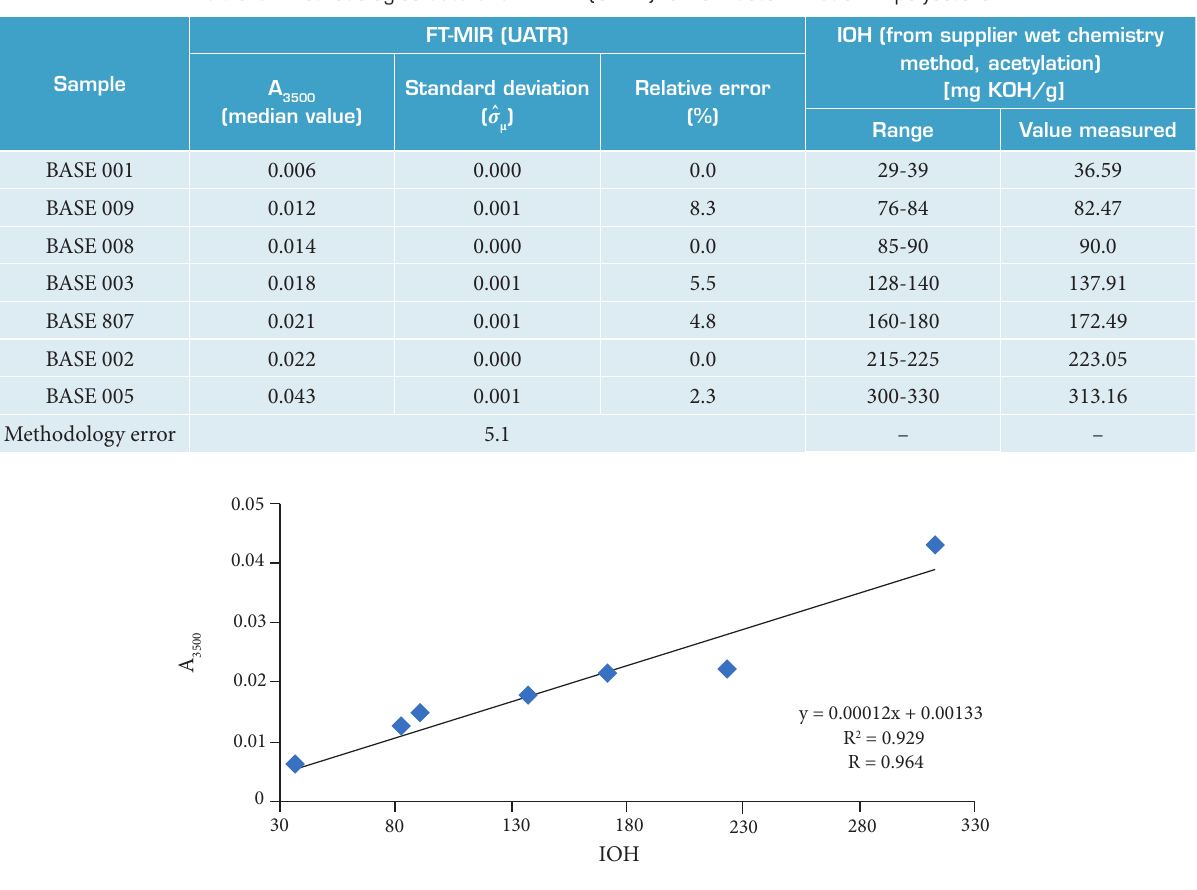
Figure 10. FT-MIR/UATR calibration curve for polyesters – A (measured by wet chemistry method, supplier’s